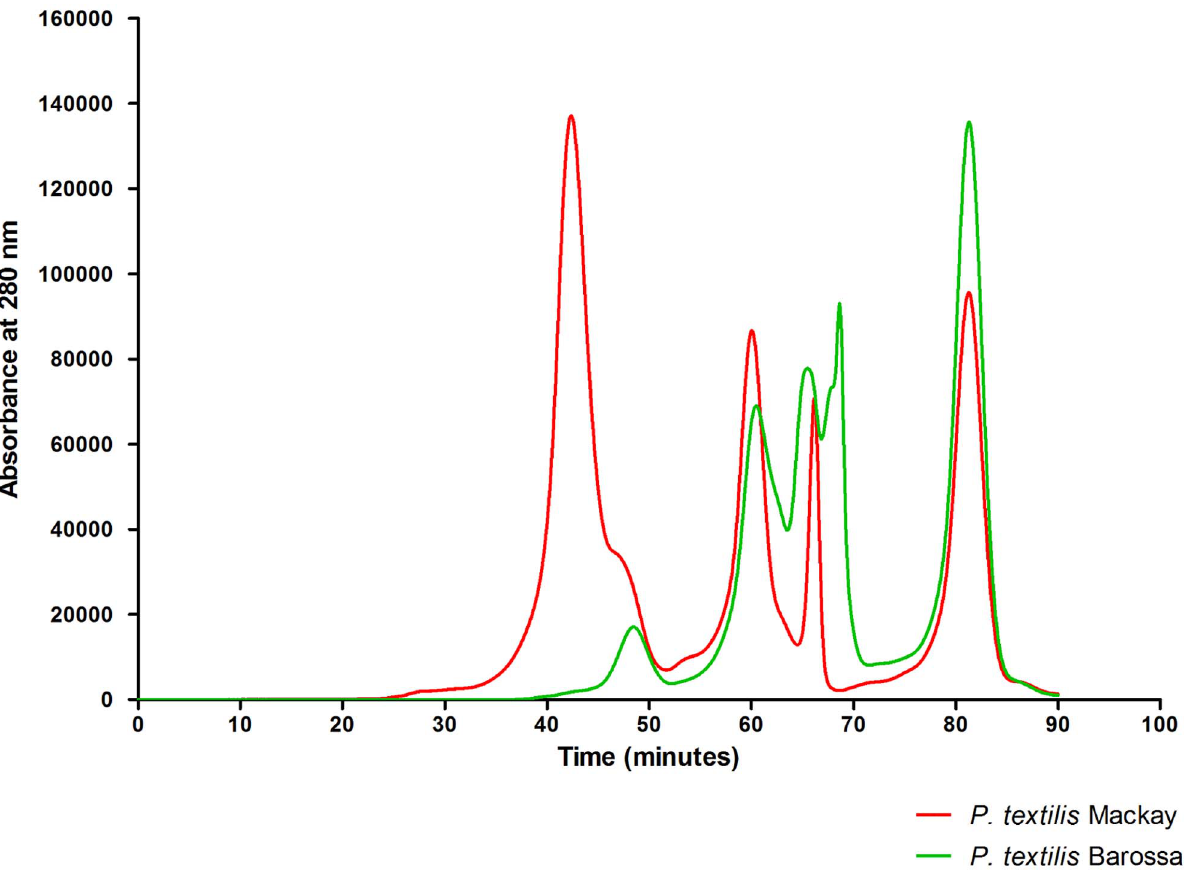
Figure 6. Size-exclusion chromatograms of Pseudonajatextilis population venoms. GE Healthcare Superdex G-200 column, 500 m l of 1 mg/ ml venom, 0.1 M pH=6.8 ammonium acetate buffer, 0.3 ml/min.